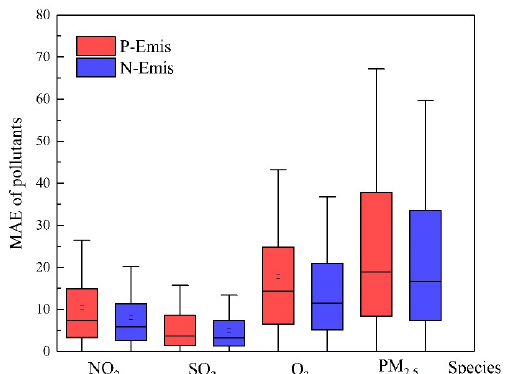
Figure 7. The MAE of NO 2 (ppbv), SO 2 (ppbv), O 3 (ppbv) and PM 2 . 5 (µgm − 3 ) concentrations based on P-Emis and